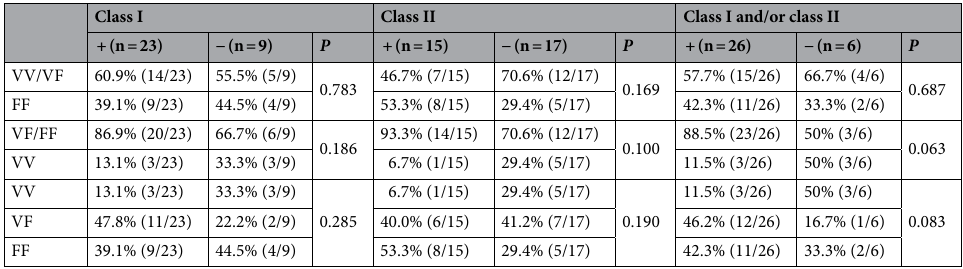
Table 3. Frequencies of FCGR3A -p.176 genotypes in RPL women with or without class I and class II antibodies. Class I and class II anti-HLA antibodies were tested in sera from 32 RPL women by Luminex Single Antigens and represented as positive (+) when antibodies were detected or negative (−) when antibodies were not detected. Women were subsequently grouped based on FCGR3A -p.176 frequencies of (VV + VF) and (FF) or (VF + FF) and (VV) or FCGR3A -p.176 VV, VF and FF.